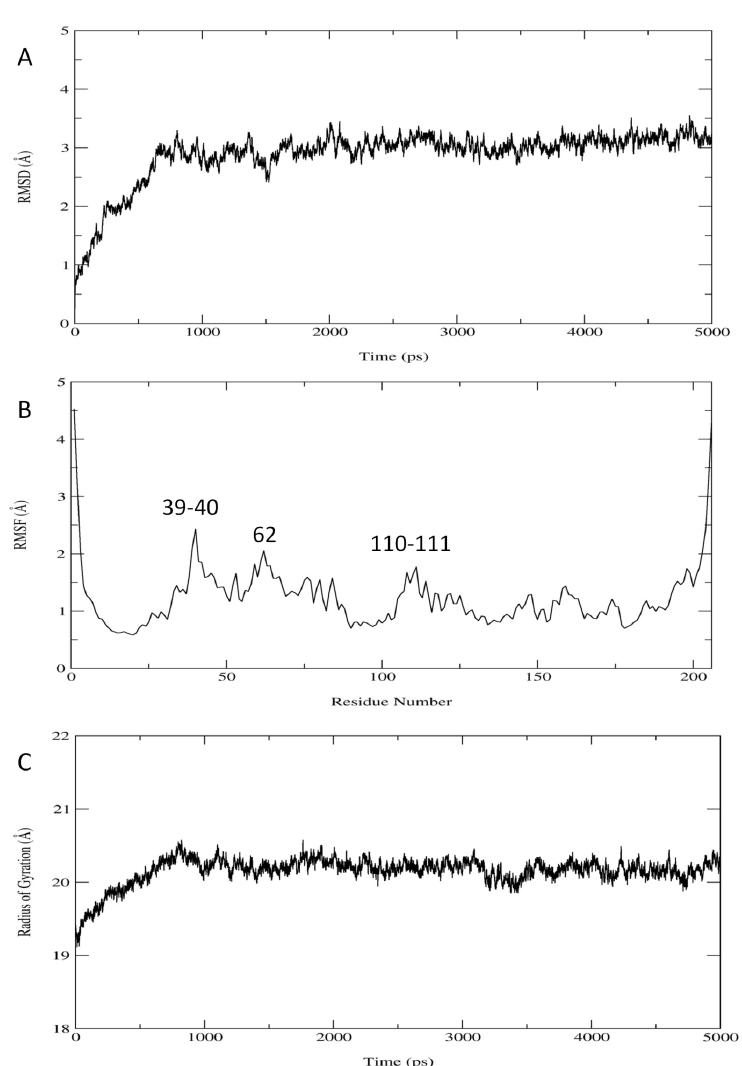
Figure 1. Analysis on ( A ) RMSD ( B ) RMSF and ( C ) Radius of gyration of Bm R1 protein during molecular dynamics